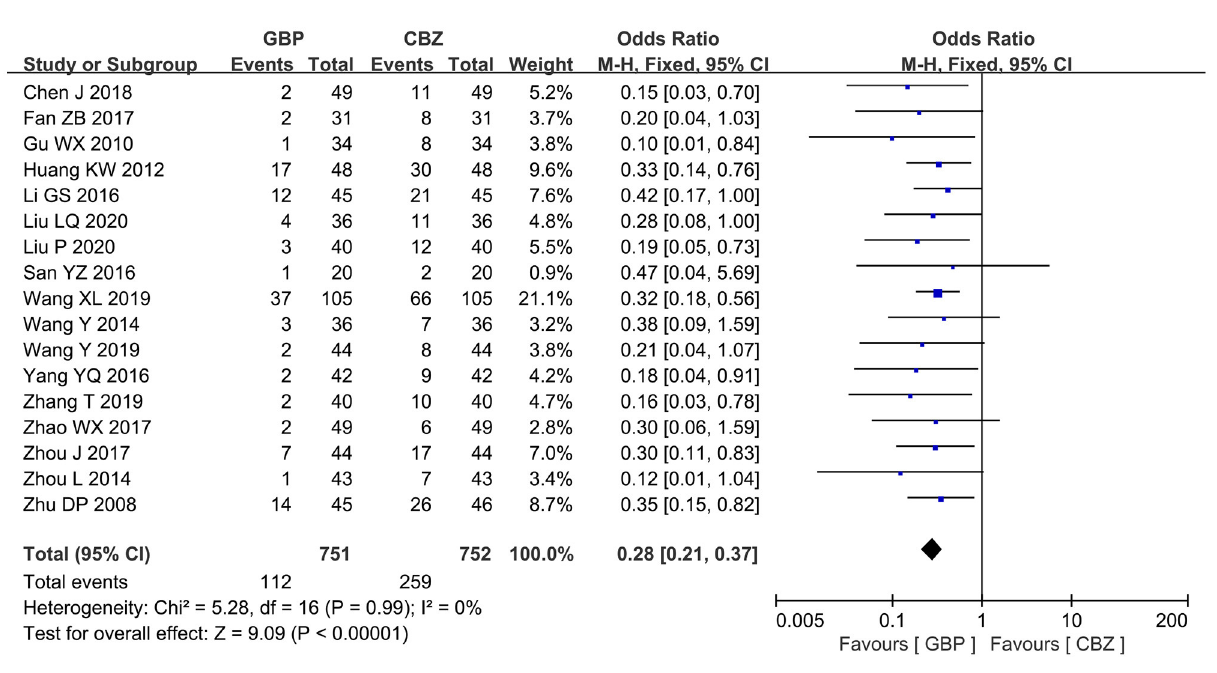
FIGURE5 Forest plot of GBP vs. CBZ: adverse event rate. GBP, gabapentin; CBZ, carbamazepine.